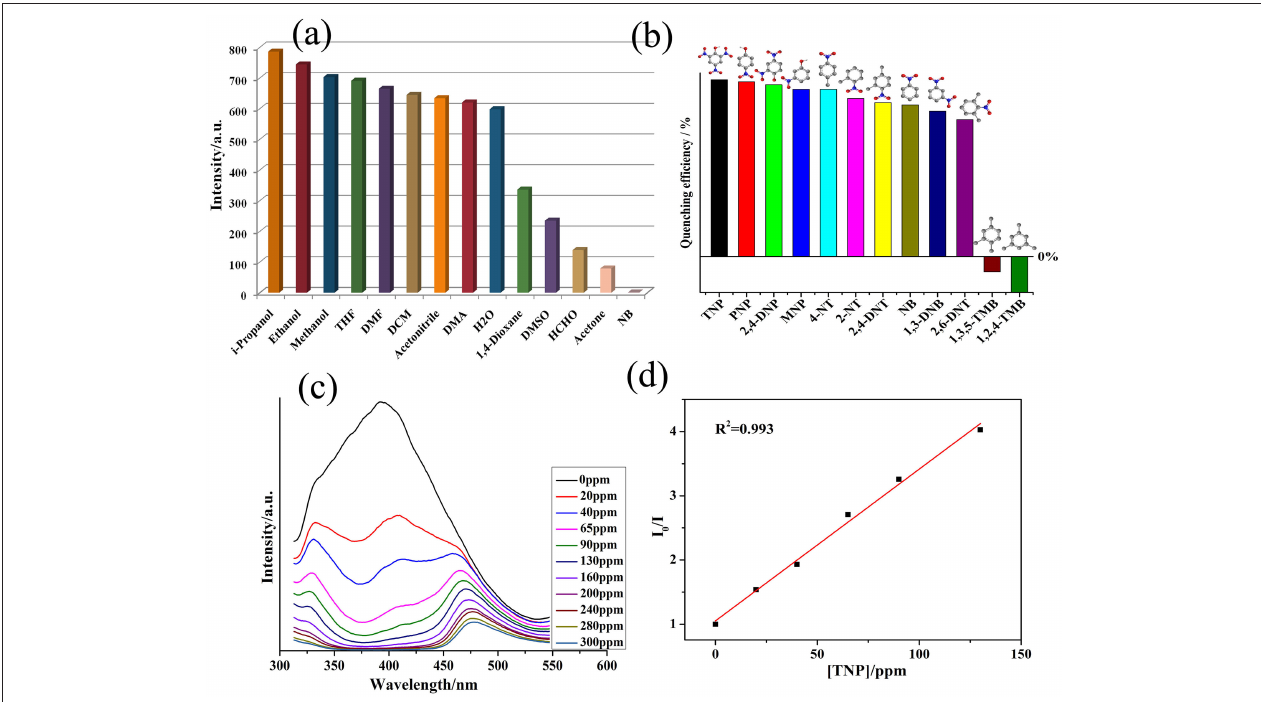
FIGURE 2 | (a) The plots of varied luminescent intensity of 1 when dispersed in different small organic molecules ( λ ex = 320nm); (b) The quenching efficiency of different nitro compounds (Emission intensities at 375nm were selected); (c) The luminescence intensity of 1 recorded after addition of 1mM TNP ( λ ex = 320nm); (d) SV plot in the presence of 1 at different TNP